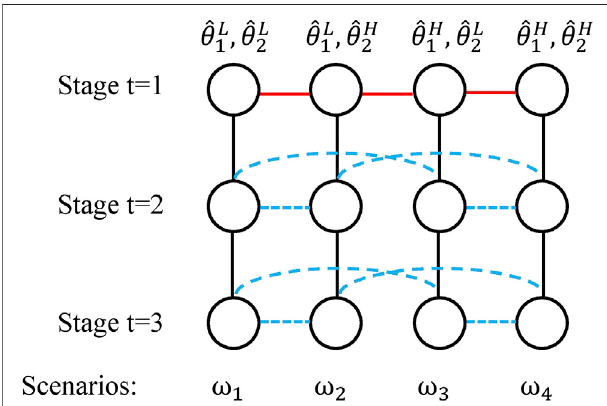
FIGURE10| Illustrationofthescenariotreeofastochasticprogramming problem under endogenous uncertainty with 3 stages, four scenarios, two uncertain parameters θ 1 , θ 2